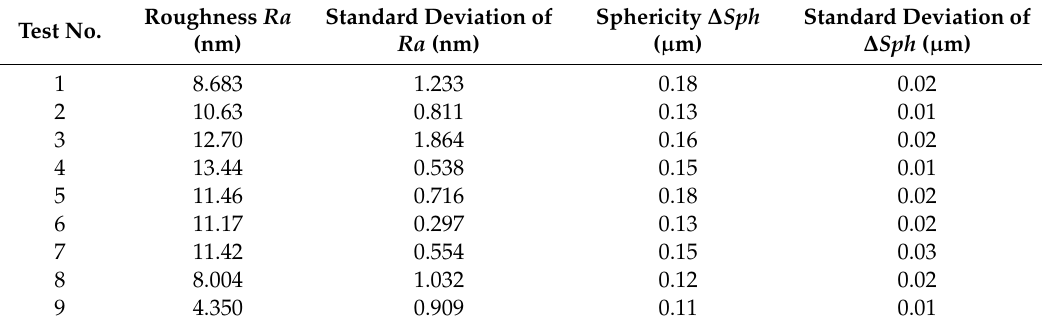
Table 4. Surface roughness and sphericity of the balls after finishing.